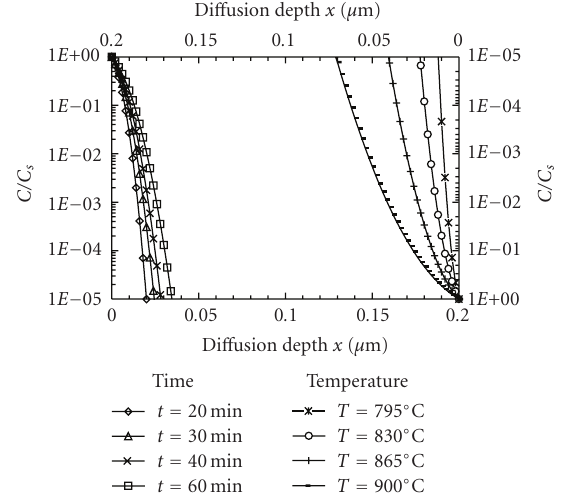
Figure 1: The profile curves of dopant concentration ratio ( C/C s ) on the corresponding di ff use distance ( x ) with changing time (on bottom-left axis) and temperature (on top-right axis) respectively, for the phosphorus di ff